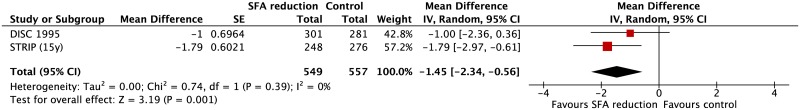
Meta-analysis of weighted mean (95% CI) differences in effects on diastolic blood pressure (mm Hg) in randomised trials that compared usual diets with reduced saturated fat diets in children.